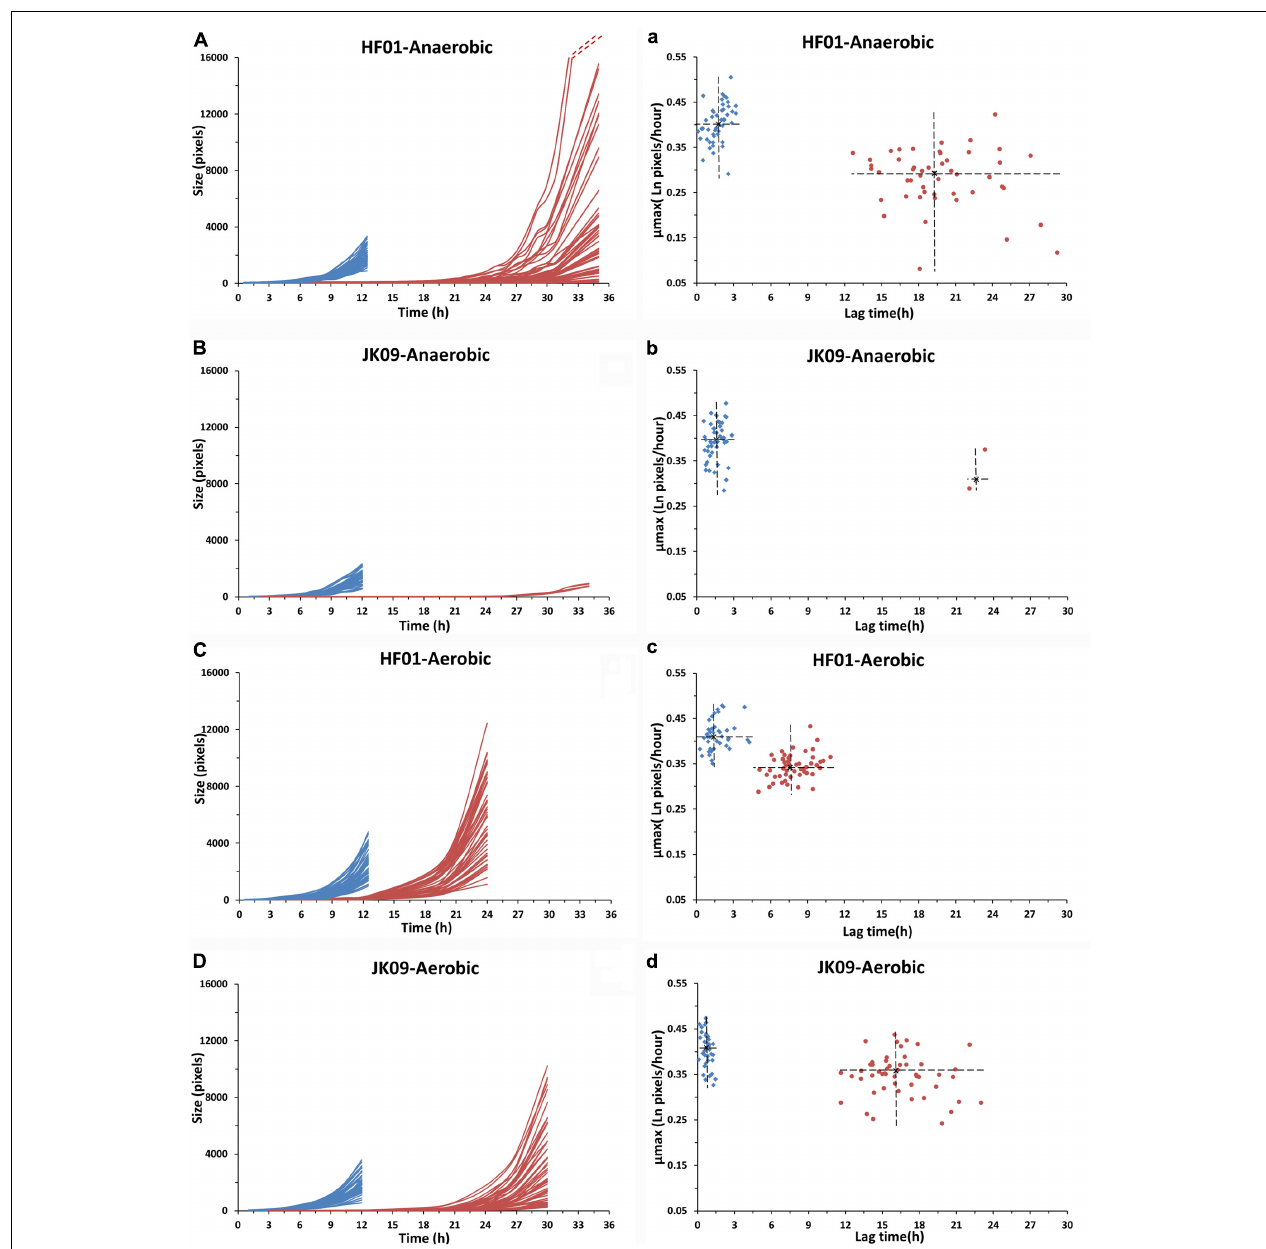
FIGURE 5 | Growth curves, lag times and μ max of individual cells of HF01 and JK09 after different treatments. Blue: after saline treatment (control); red: after PAA treatment.The dotted red lines indicate that the two fastest growing microcolonies reached approximately 31000 pixels at 35 h.The center of the cross is the median of lag time and μ max (a–d)